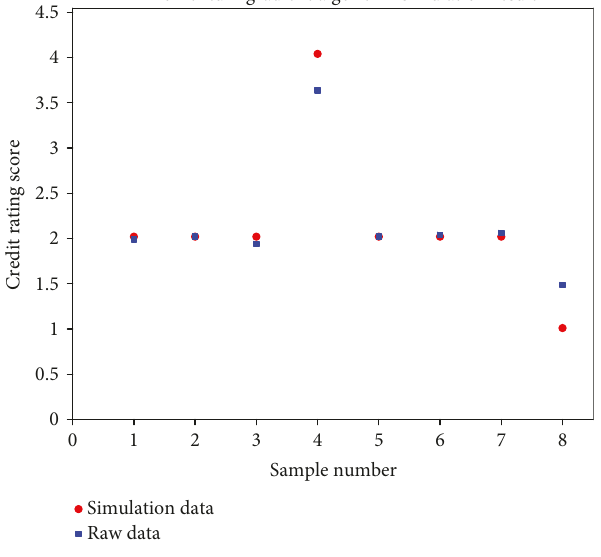
Figure 13: Momentum gradient test